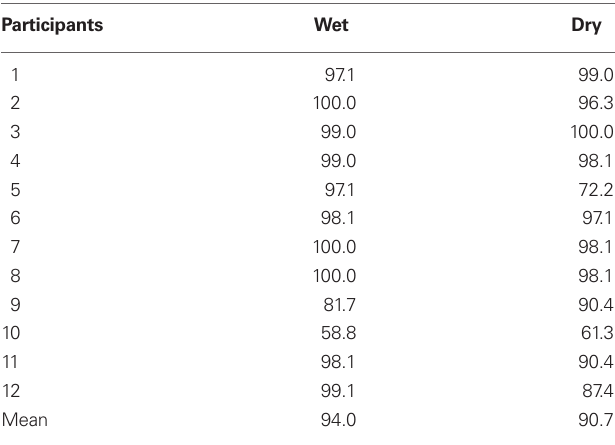
Table 3 | Brain–computer interface results of the alpha paradigm. Classification results for all